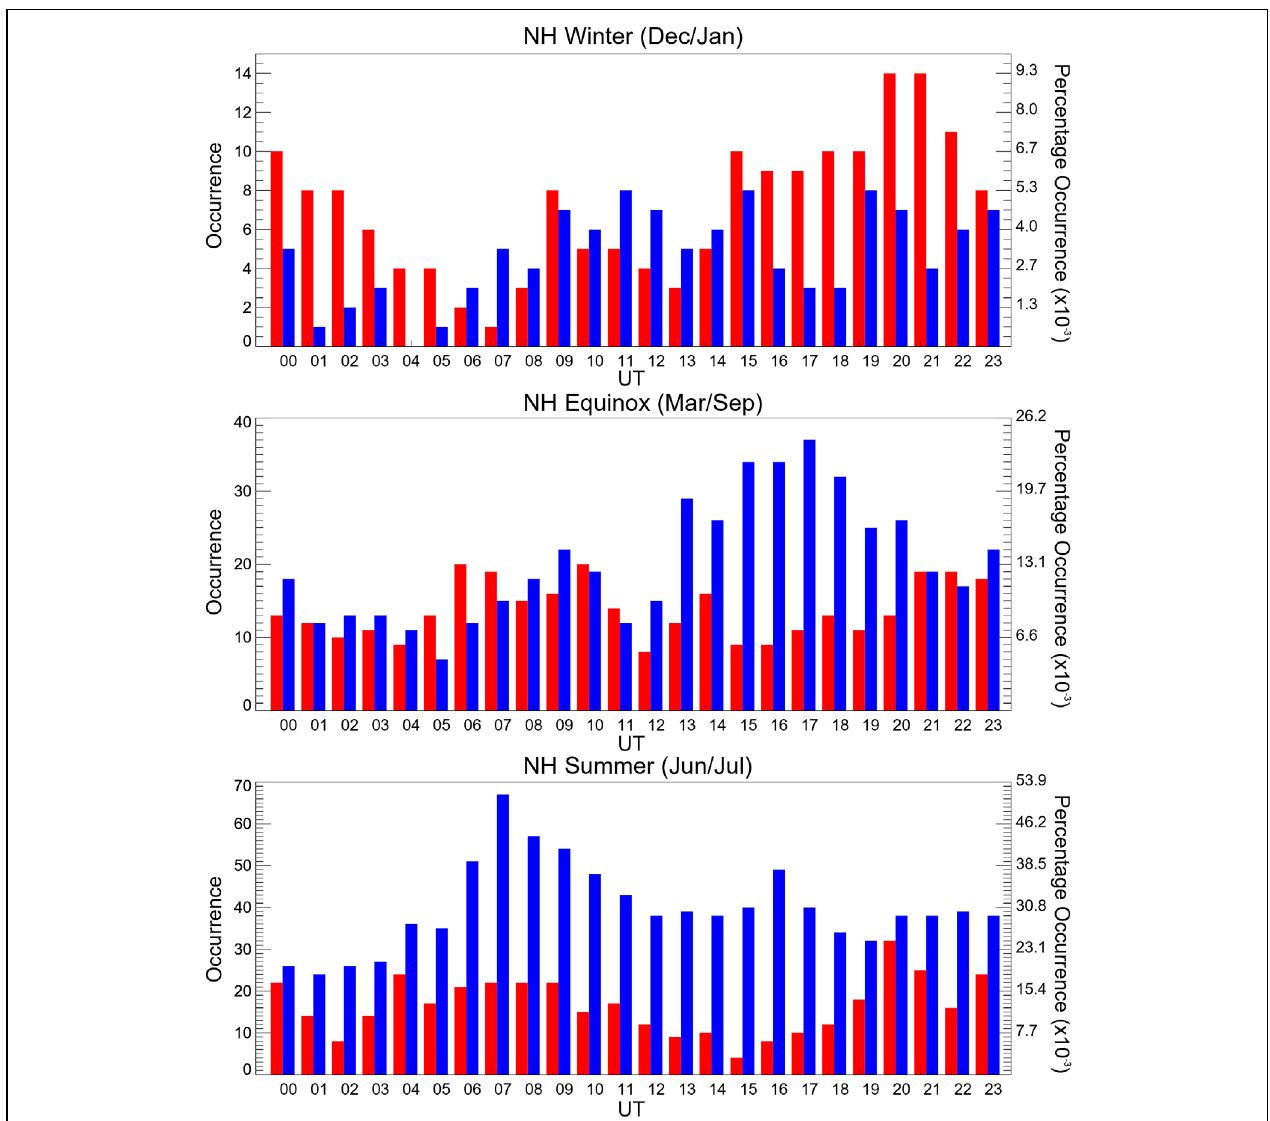
FIGURE 4 | The UT occurrence distribution of R2Bs from 2011 to 2014, for the northern hemisphere split by season: (top) northern winter (December/January) (middle) northern equinox (March/September), and (bottom) northern summer (June/July). The right-hand axis shows the percentage occurrence. Red showing dawn and blue showing dusk